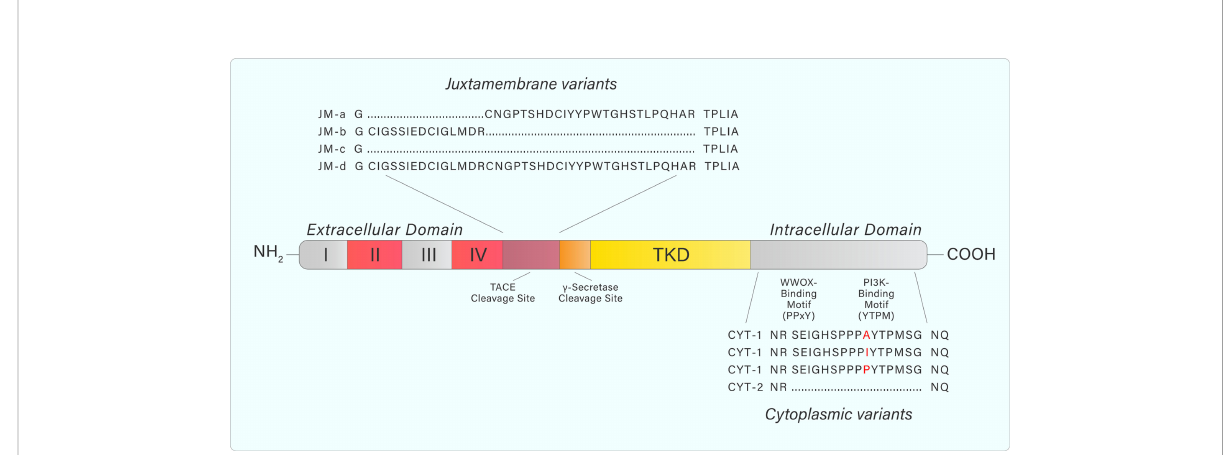
FIGURE 3 Adapted from Donoghue et al. Graphic representation of ERBB4 juxtamembrane (JM-a, b, c, d) and cytoplasmic (CYT-1, 2) variant sequences. JM-a- and JM-d variants contain tumor necrosis factor converting enzyme (TACE) and g -secretase cleavage sites causing release of the extracellular domain and subsequent release of a soluble intracellular fragment. Variants containing JM-b and JM-c do not undergo cleavage and remain as a full-length receptor. CYT-1-containing variants include a 16-amino acid sequence that contains WW domain-containing oxidoreductase (WWOX)- and PI3K-binding motifs. These binding motifs are absent from CYT-2-containing variants. Amino acid sequences were generated from the NCBI Nucleotide database.